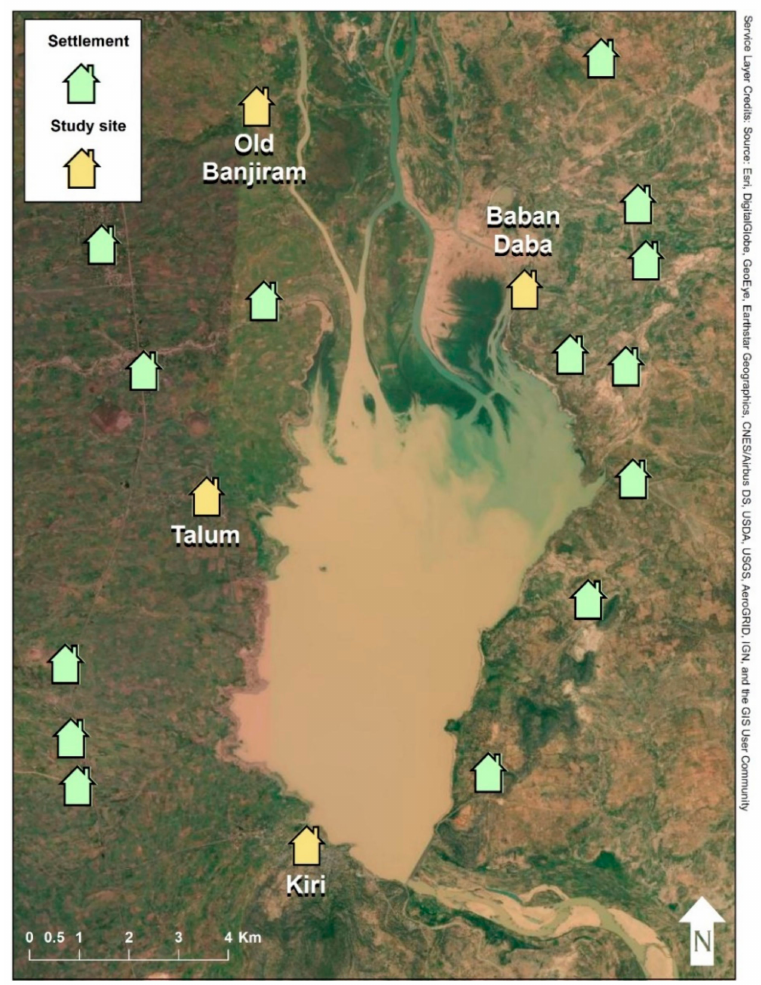
Figure 2. The four communities included in this study were Kiri (largest), Baban Daba (smallest), Talum, and Old